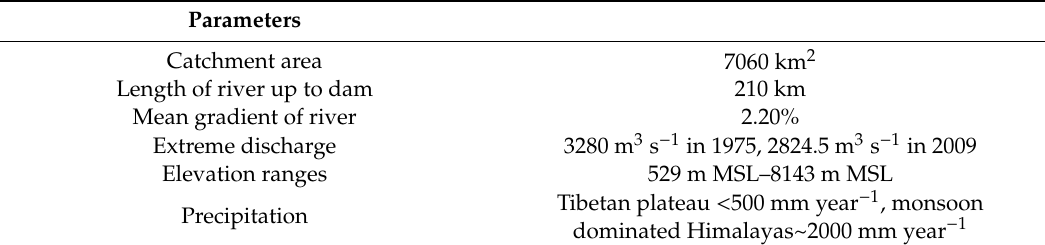
Table 1. Main characteristics of the river